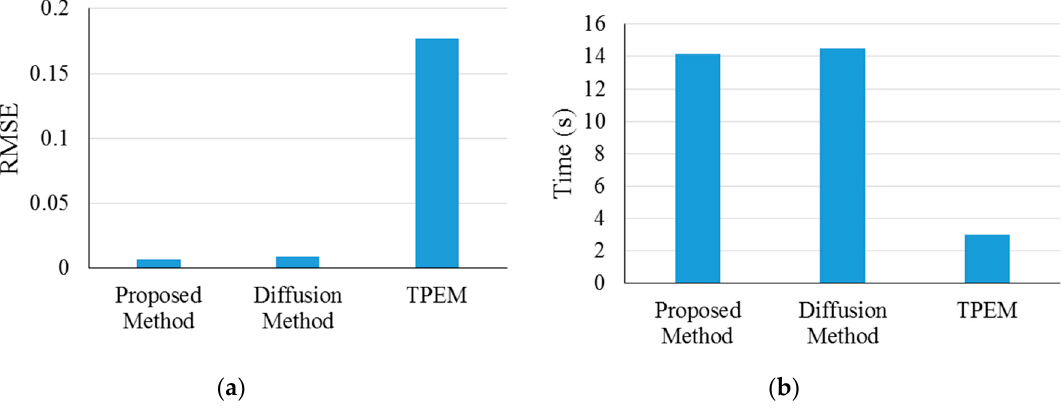
Figure 16. Results for the study by Kazemdehdashti (2018) [94] in terms of ( a ) root mean squared error (RMSE) and ( b ) time. Table 10. Application of Bayesian methods in the field of electrical machines and power systems. Reference